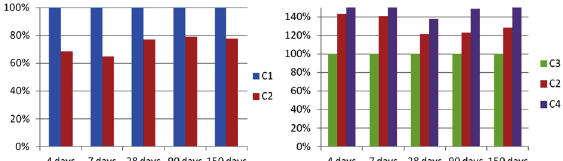
Fig. 13. Effect of the use of natural pozzolans and change in amount of ITZ in compressive strength